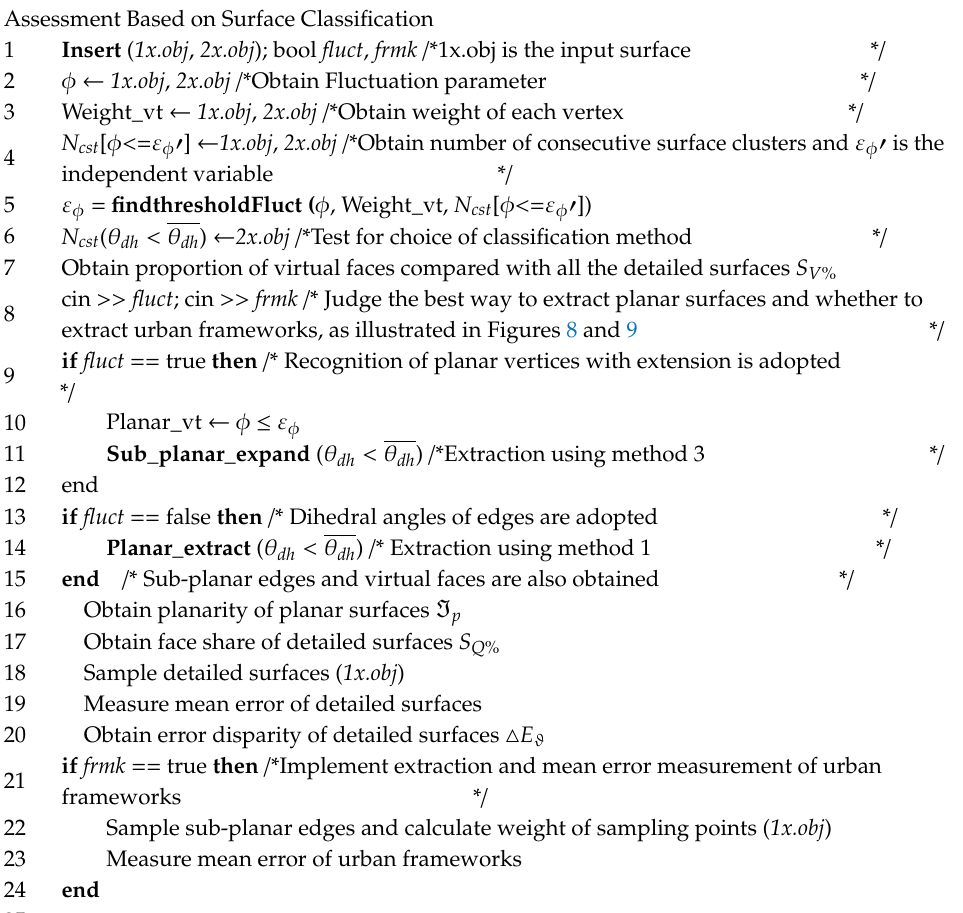
Algorithm 1. Implementation of multifaceted geometric assessment for simplified